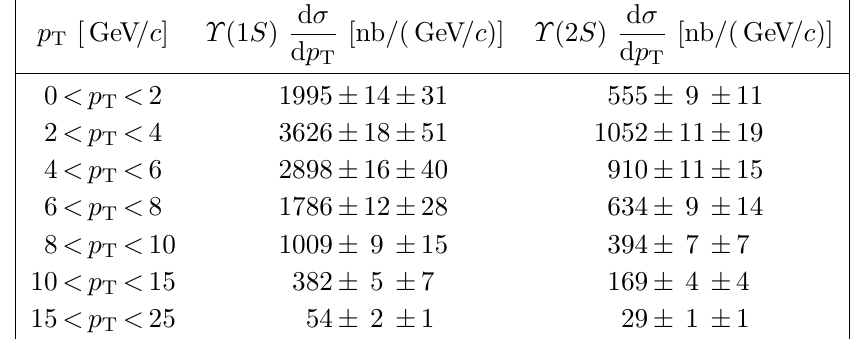
p s = 8 : 16 TeV. The (cid:12)rst uncertainty is NN